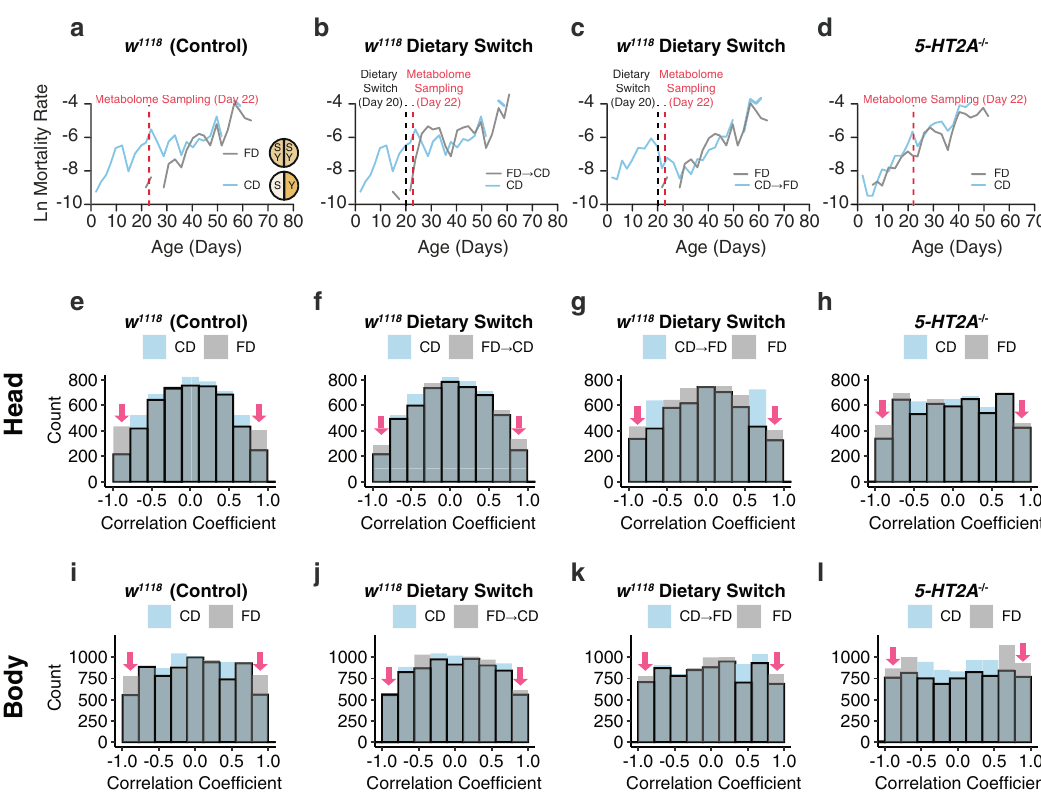
Fig. 1 Dietary choice in fl uences both mortality and metabolite correlations in metabolomes through serotonin signaling. a – d Mortality data, which are from our recent publication (Lyu et al. 31 also see our permission statement), are used to demonstrate the association between aging and metabolite correlations under nutrient choice. Mortality rate is plotted on the natural log scale ( N = 225 – 282). a Control males fed on a choice diet exhibit higher mortality rates early on compared to their siblings on a fi xed diet. b , c Switching to a different diet (applied at 20 days of adulthood, as denoted by the dashed line) immediately changes the mortality rates that re fl ect the in fl uences from the new diet. d 5-HT2A mutants are immune to the choice-induced mortality effects. e – l Dietary choice in fl uences correlations between metabolites in metabolomes. Control males fed a choice diet have less highly correlated metabolite pairs (indicated by red arrows) compared to their siblings that fed a fi xed diet in both heads ( e ) and bodies ( i ). Either dietary switch ( f , g , j , k ) or a mutation in 5-HT2A ( h , l ) diminishes the dietary differences, mirroring the effects on